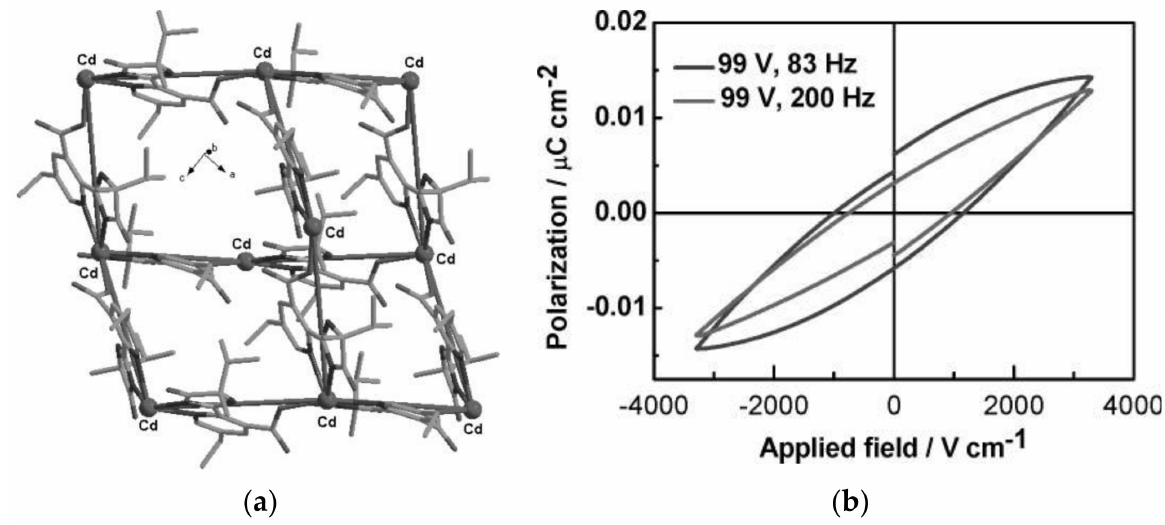
Figure 7. ( a ) The diamond-like net of MOF based on [Cd(imazethpyr)] and ( b ) electric hysteresis loop of the MOF. Dalton Trans. 2008, 3946–3948 ([223])—Reproduced by permission of The Royal Society of